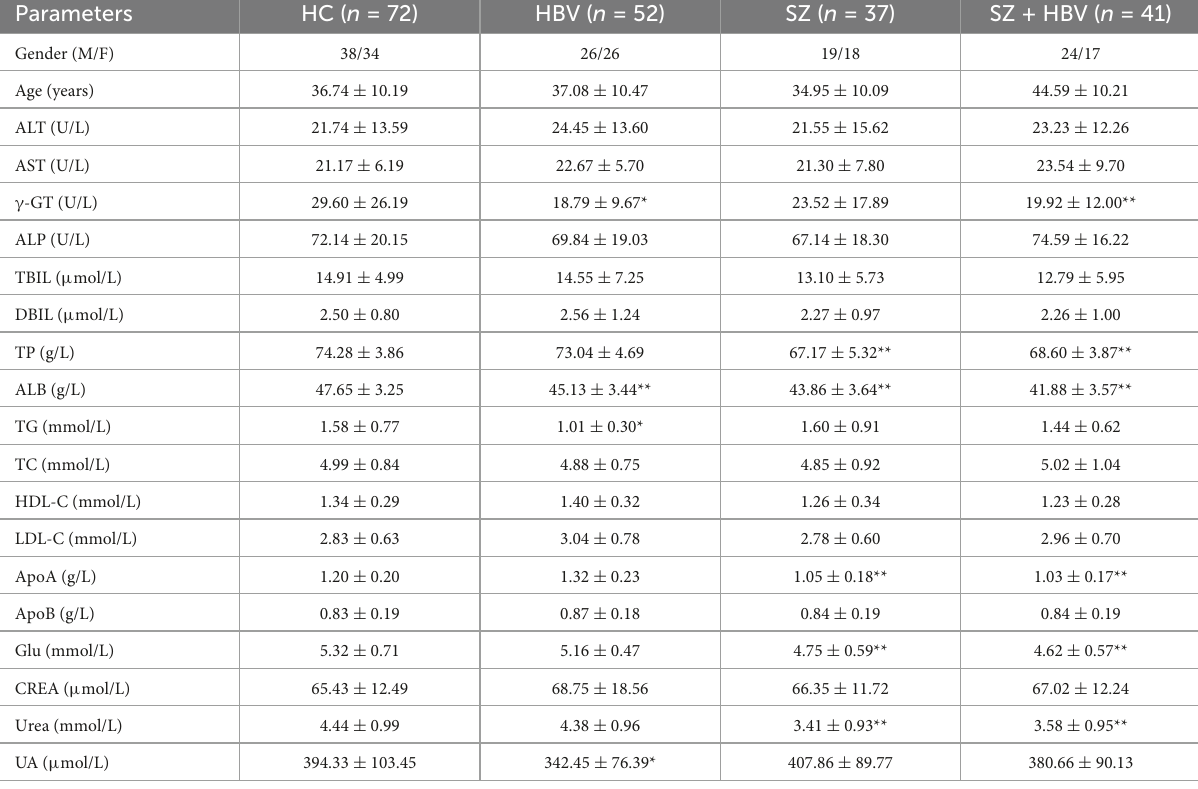
TABLE 1 Basic clinical and biochemical characteristics in different